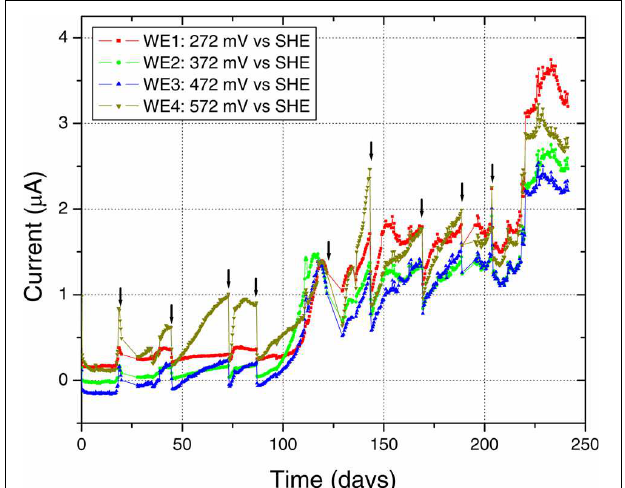
FIGURE 2 | Electrochemical enrichment. The increasing anodic current vs. time indicates the enrichment of microbial communities capable of mediating extracellular electron transfer to the four WEs. Arrows indicate times of medium change, which resulted in an abrupt decrease of anodic current before recovery of the increasing